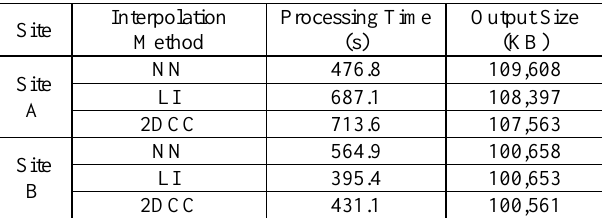
Figure 6. DEM result of Site A using (a) Nearest Neighbor; (b) Linear Interpolation; and (c) Cubic Convolution The size of the grid is determined by the extents of the coordinates of the ground control points. For this study, 1cm was set as the default raster cell width, since the software usually crashes at less than 1cm. Table 7 describes the sample outputs of the different interpolation methods used in the generation of DEM for the Site A and B inputs. Table 7. Processing time and output size of the DEMs summary